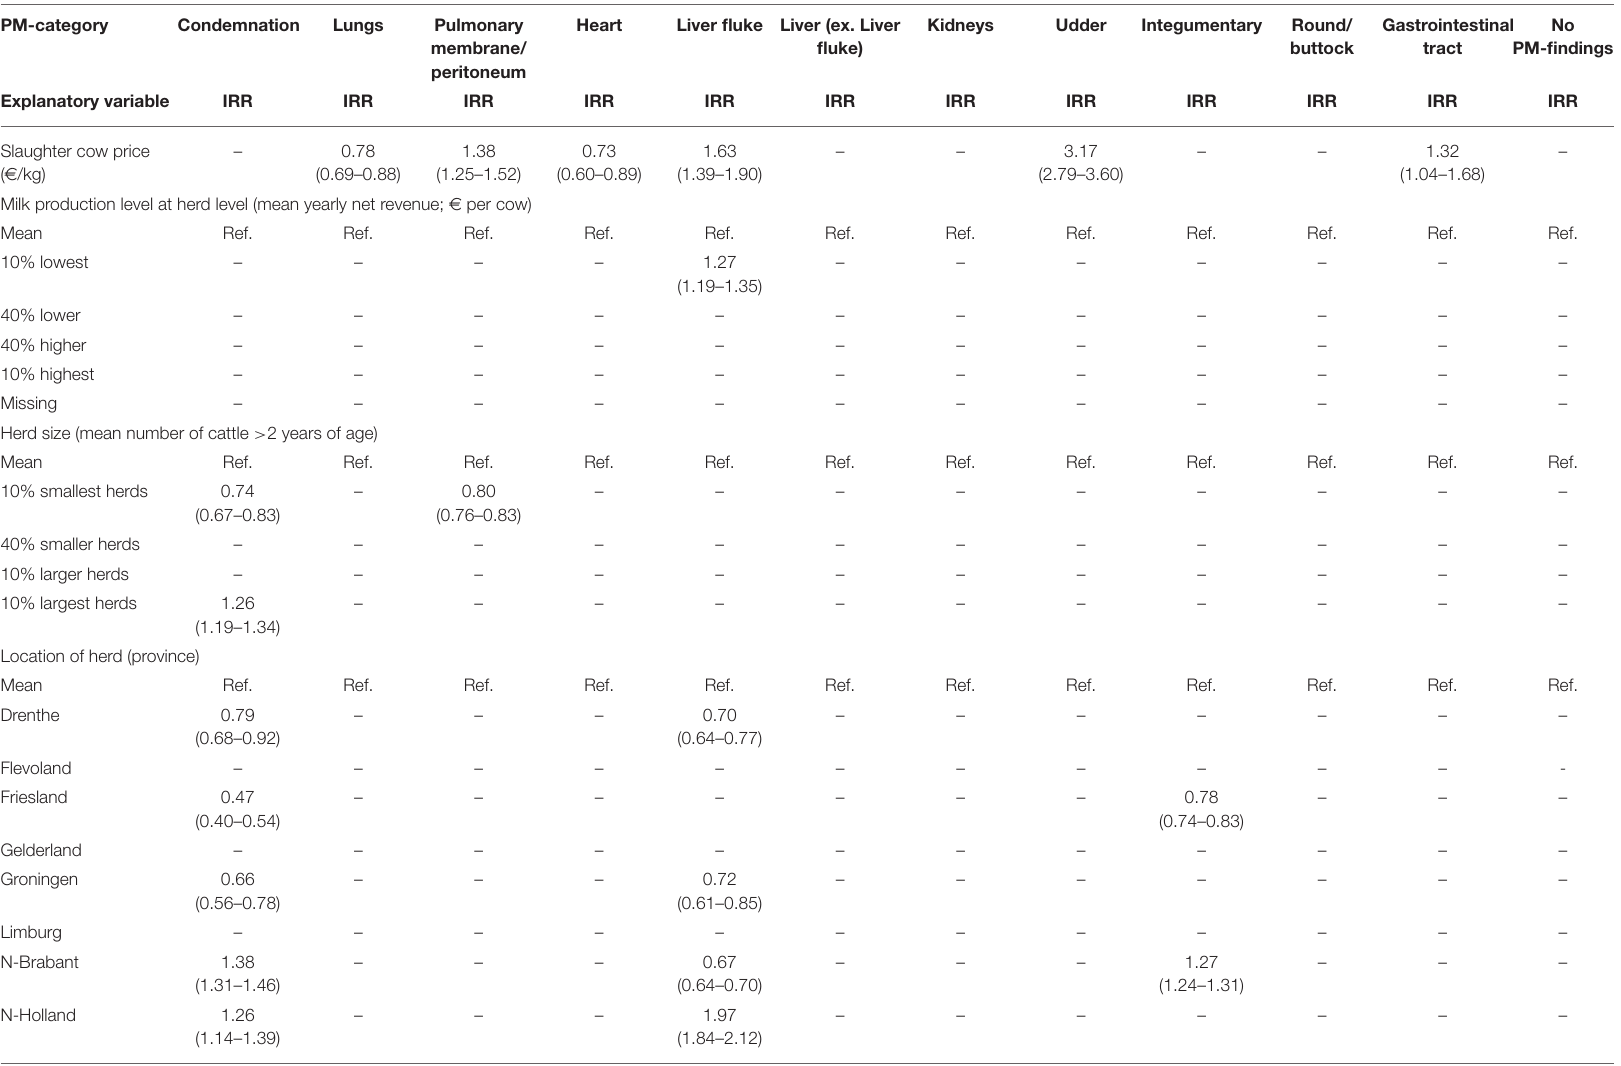
TABLE 5 | Results of multivariable analyses of PM-findings amongst slaughtered cattle from dairy herds between January 1, 2015 and September 30, 2018, in incidence ratios (IRR) and 95% confidence intervals. Only associations with a p-value < 0.05 that met the relevance criteria (IRR ≤ 0.8 or ≥ 1.25) are shown (N =